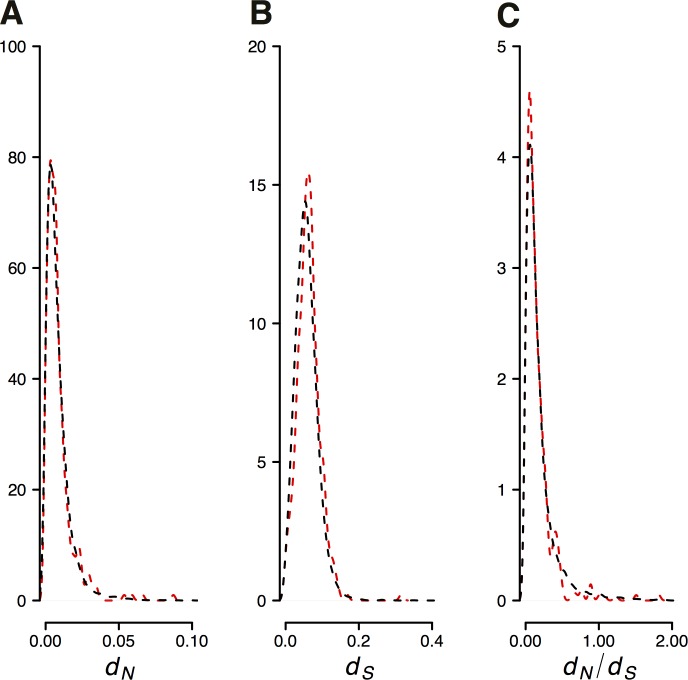
Evolutionary rates along X-chromosome (LG12) and autosomes.Density plots (A) of the rates of nonsynonymous (dN), (B) synonymous substitutions per nucleotide (dS) and (C) the ratios of dN and dS (dN/dS) between LG12 (red dashed lines) and autosomes (black dashed lines).